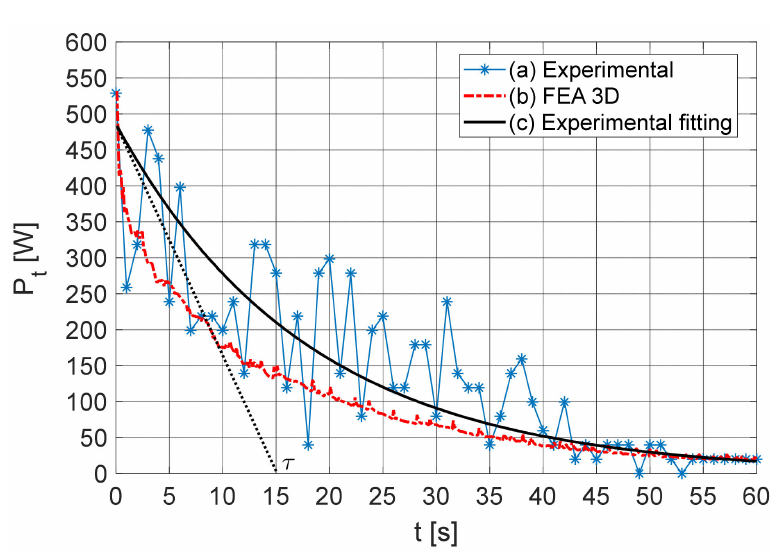
Figure 9. Evolution of thermal power release from the YBCO